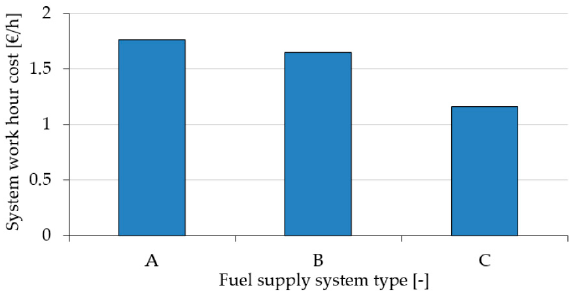
Figure 14. Cost per hour of chipper operation with the selected drive system.